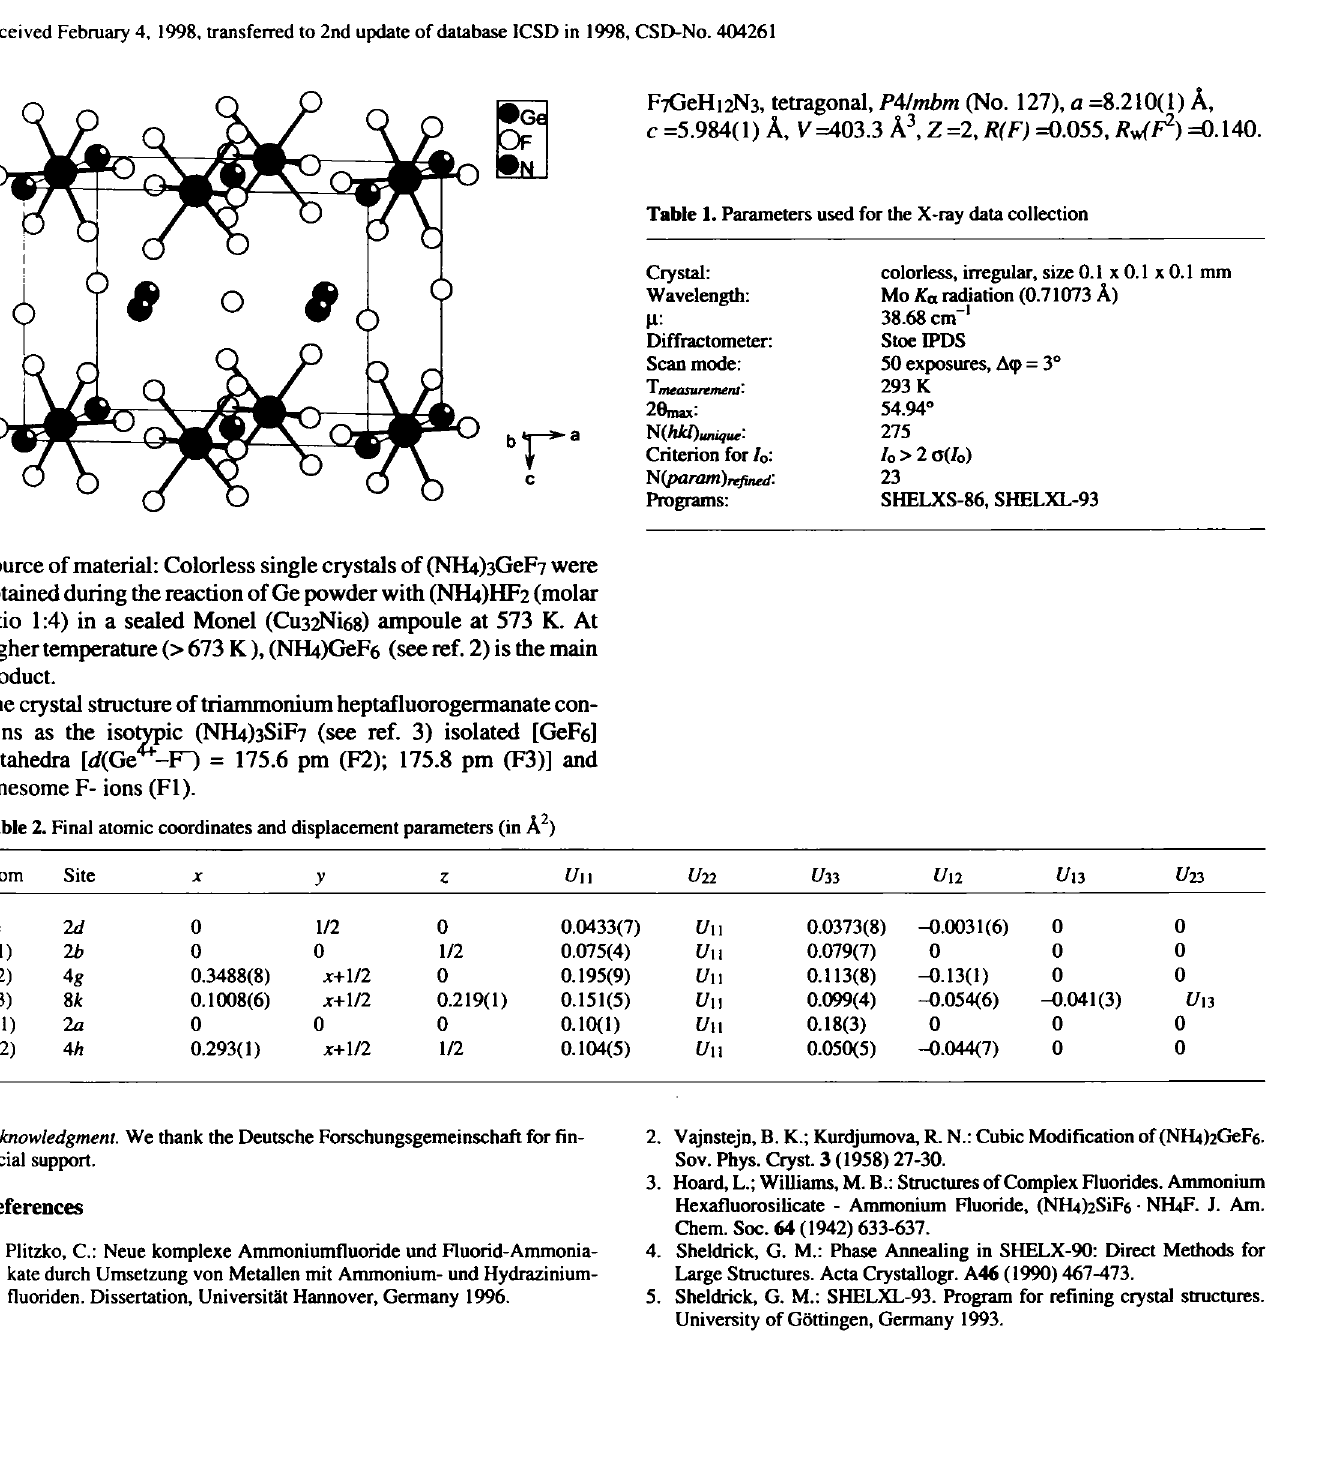
Table 1. Parameters used for the X-ray data collection Crystal: